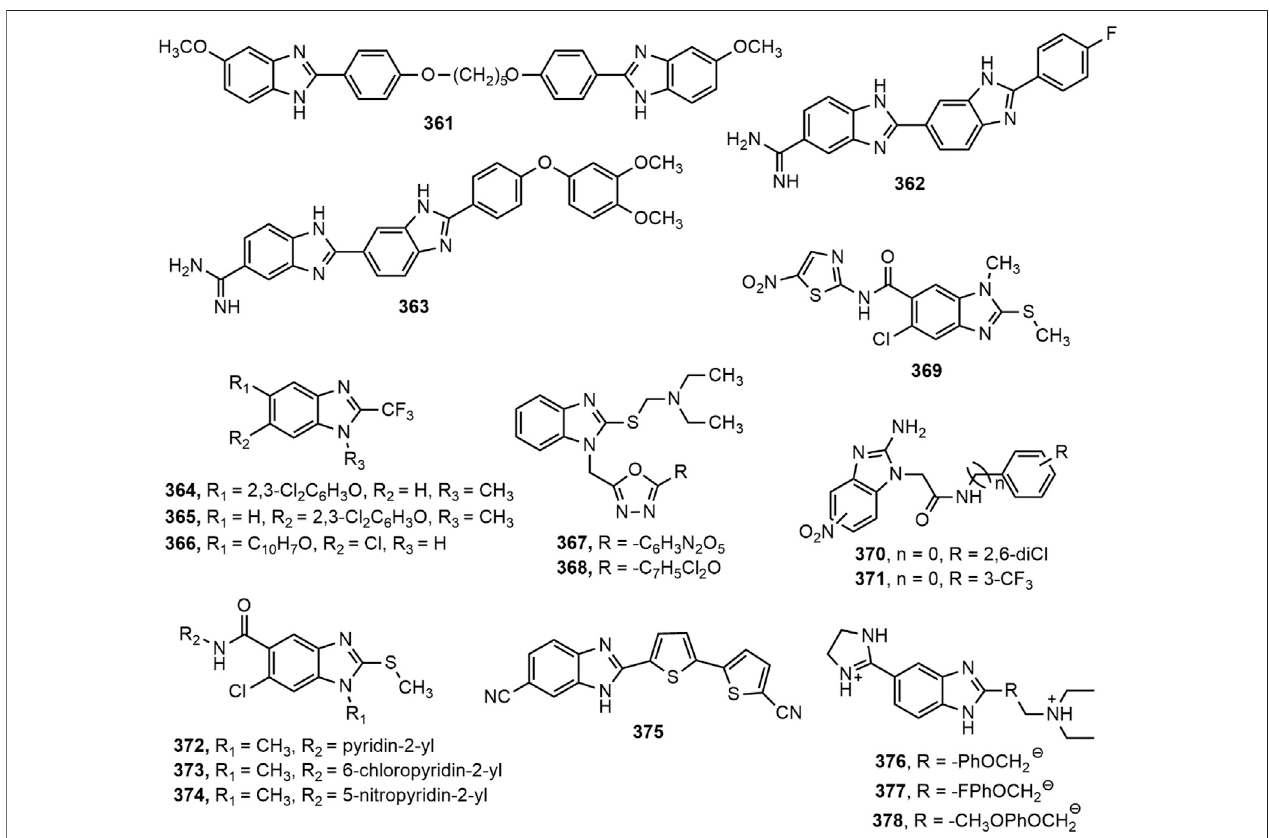
FIGURE 14 | Benzimidazole derivatives with antiprotozoal